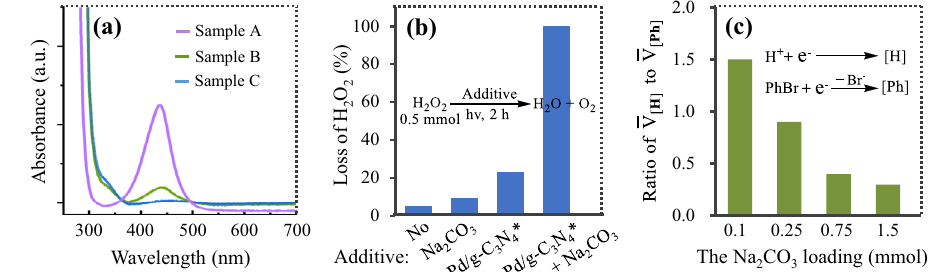
decomposition in the presence of additives. c Effect of the Na 2 CO 3 loading on the ratio of V ½ H (cid:2) to (cid:1) V ½ Ph (cid:2) . PhBr: bromobenzene. [Ph]: intermediate regarding phenyl radical, [H]: intermediate regarding hydrogen radical. (cid:1) V ½ H (cid:2) and (cid:1) V ½ Ph (cid:2) represents the average rate of the [H] and [Ph] production in 4h, respectively. Source data are provided as a Source Data fi